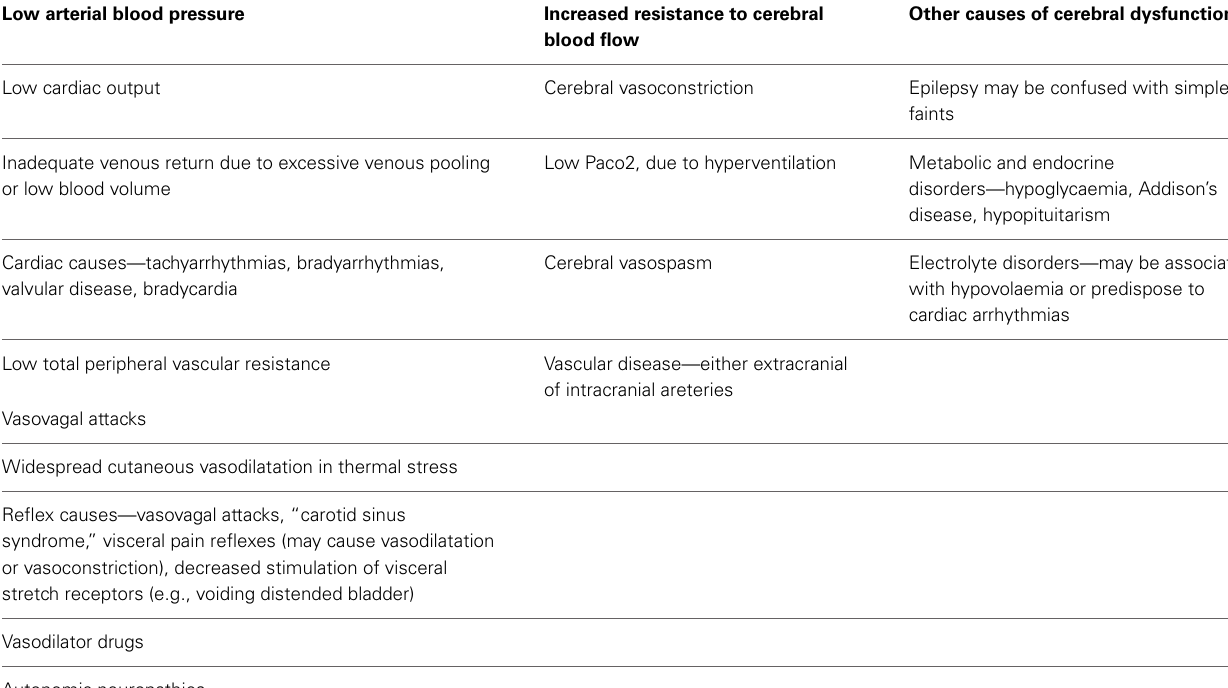
Table 4 | Classification and causes of